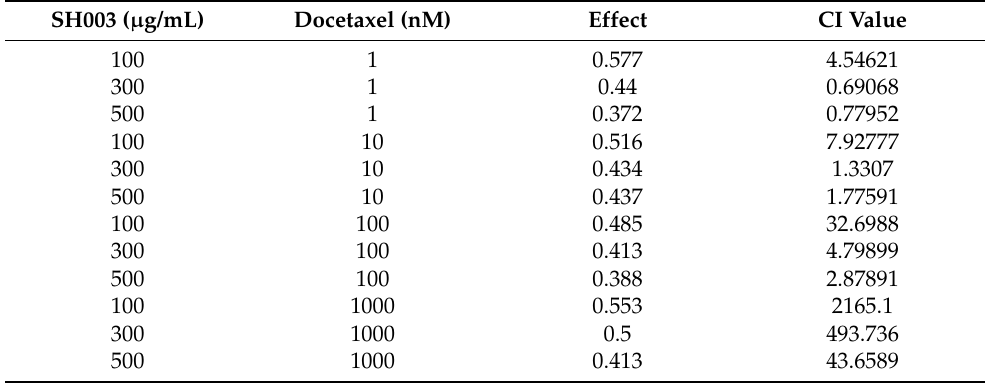
Table 1. Combination index values of SH003 and docetaxel combinations treatments in H460 cells. SH003 ( µ g/mL) Docetaxel (nM)